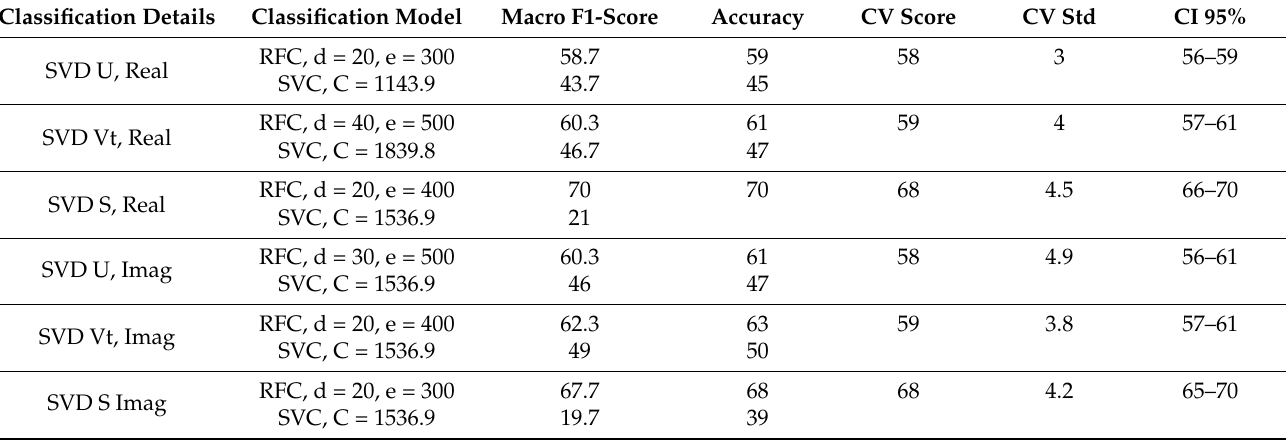
Table 6. Healthy vs COPD vs Pneumonia classification of parameter tuning results. In these, d stands for depth, and e stands for the number of